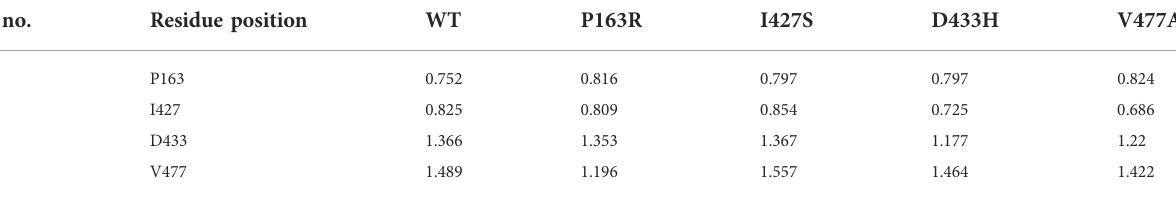
TABLE 2 Comparative average RMSF values (in angstrom) at mutation speci fi c position throughout the simulation. S.